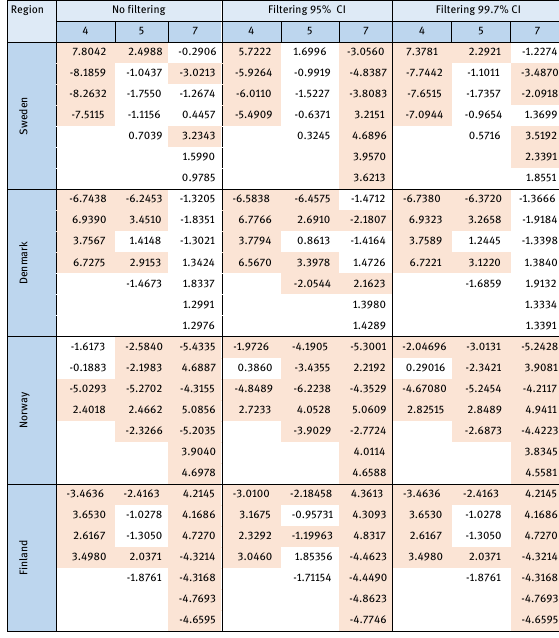
Table 3. Standardised estimated parameters from least-squares detrending process with discrepancies, before and after filtering the discrepancies by CIs of 95% and 99.7%, column 4, 5 and 7 rep- resents the number of parameters in each corrective surface model [unitless] Region No filtering